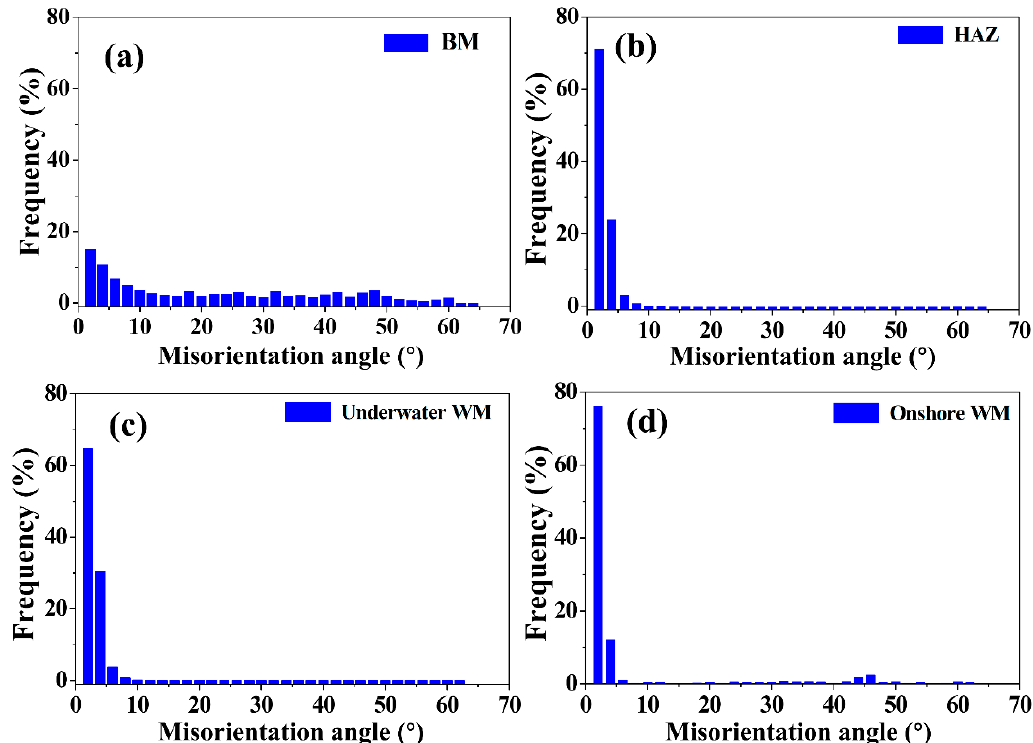
Figure 8. Grain boundary misorientation-angle distribution (GBMAD) of ferrite for the ( a ) BM, ( b ) HAZ, ( c ) underwater WM, and ( d ) onshore WM.